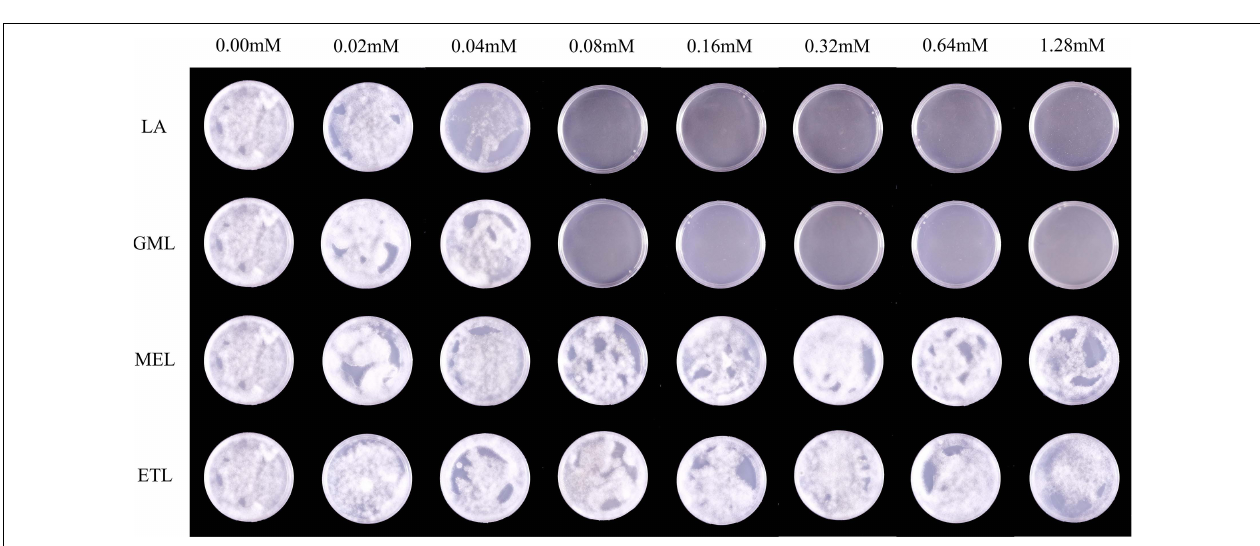
FIGURE 3 | Effect of LA on P. sojae mycelial morphology. Mycelia were treated with LA or the same volume of water (CK) for 2 h before their morphology was analyzed. Mycelial growth after LA treatment was disorderly, the terminal branch number increased significantly, and the formation of zoosporangium was inhibited. In CK, the mycelium grew normally and expanded without any distortion, bending, or increased terminal branching. The experiment was repeated three times with similar results.